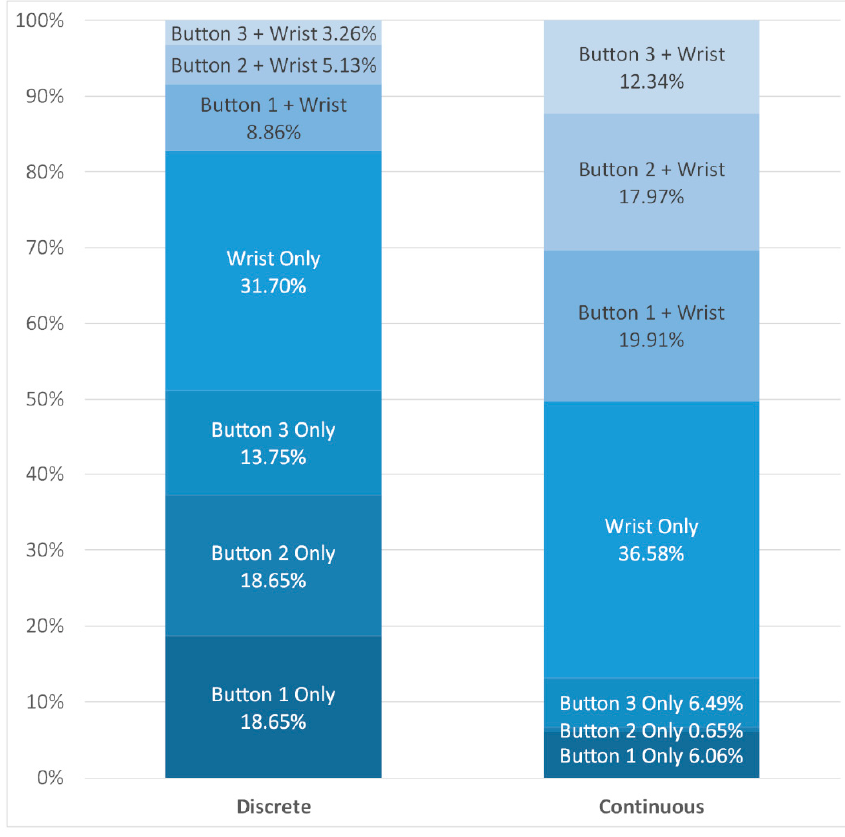
Figure 5. Observed percentages of wrist and touch gestures for HAR interactions. Button one was highly preferred for both simple and complex gestures. Simple wrist gestures were preferred for continuous tasks and simple touch gestures for discrete tasks (shows a clear influence of prior experience).